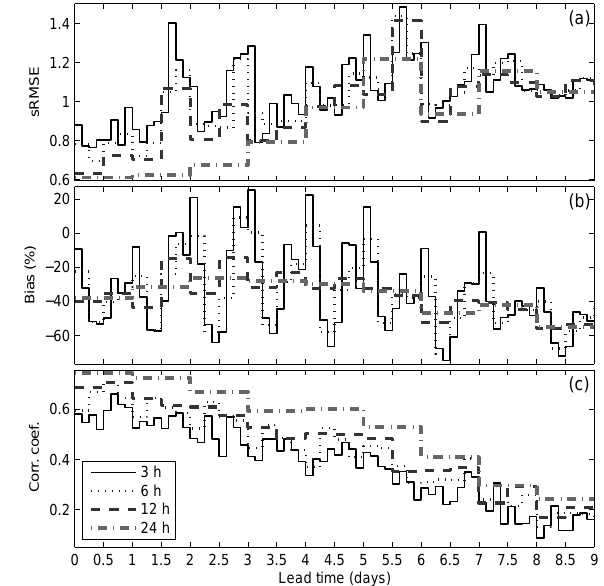
Fig. 8. A comparison of the evaluation scores of the ACCESS-G model for different temporal precipitation accumulation periods at Carboor Upper station: (a) sRMSE, (b) bias, and (c) Spearman cor- relation